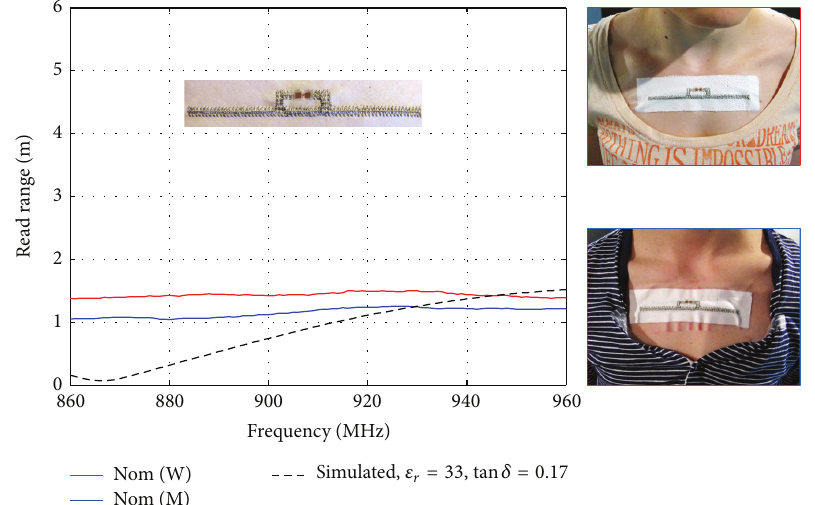
Figure 18: Measured and simulated embroidered tag on human chest and on human chest model,